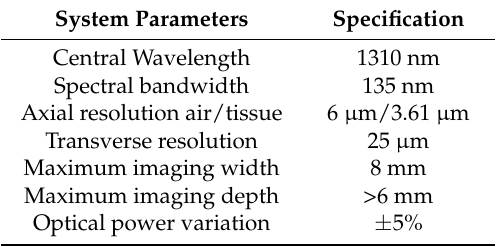
Table 1. The details of the optical frequency domain imaging system.